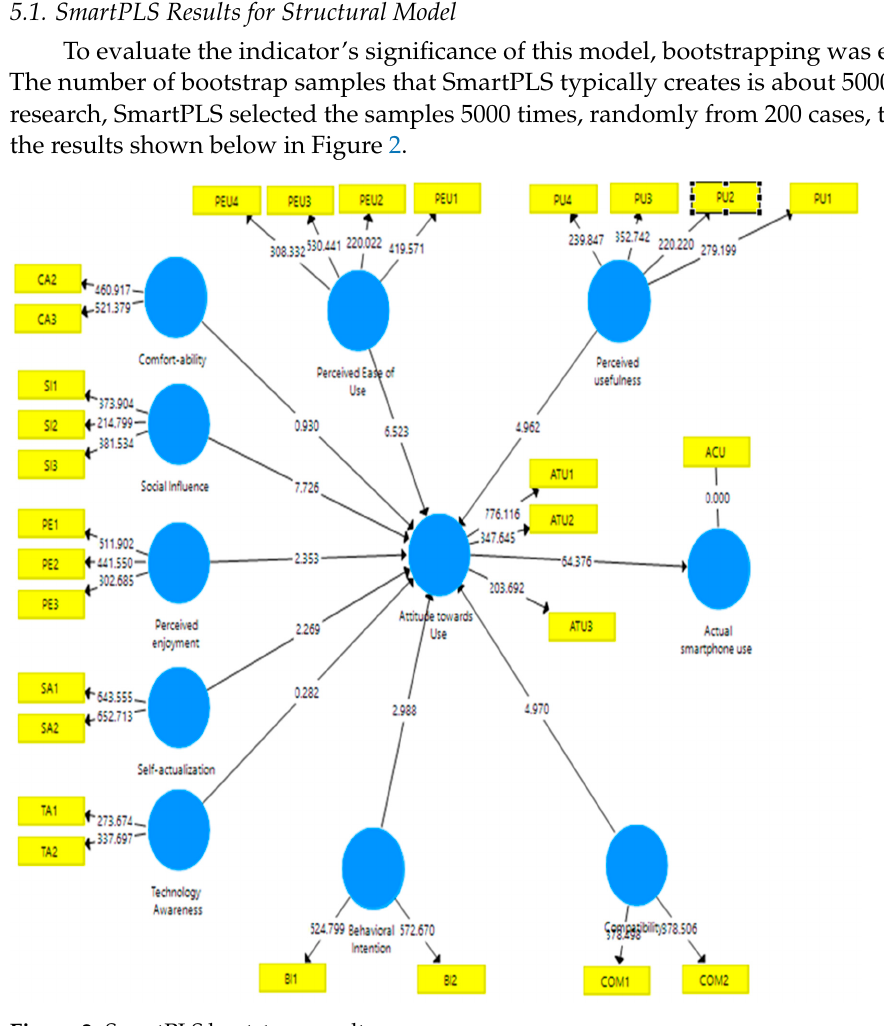
Figure 2. SmartPLS bootstrap